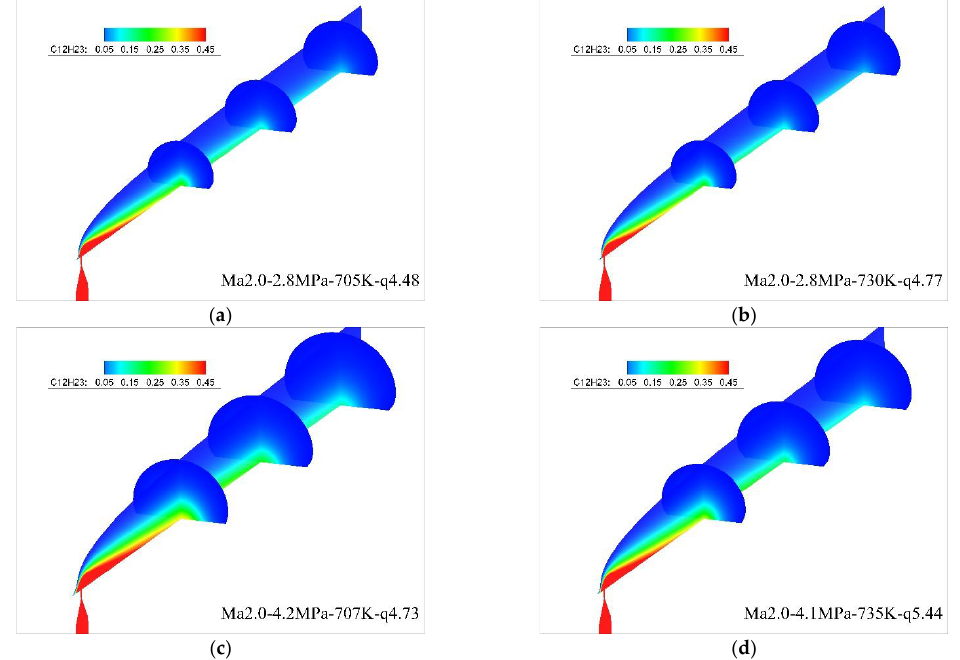
Figure 13. Mass fraction of EHF in central plane and cross-sectional plane. ( a ) Ma = 2.0, P j = 2.8 MPa, T j = 705 K. ( b ) Ma = 2.0, P j = 2.8 MPa, T j = 730 K. ( c ) Ma = 2.0, P j = 4.2 MPa, T j = 707 K. ( d ) Ma = 2.0, P j = 4.1 MPa, T j = 735 K.